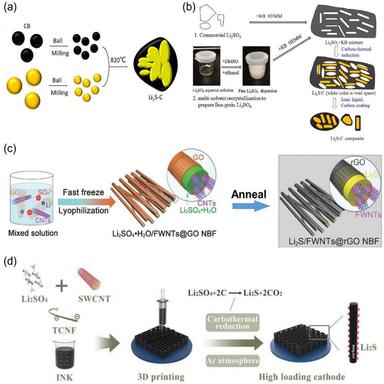
The schematic of different methods for making Li2S-C composites via carbothermal reductions based on elemental carbon. (a) Ball-milling Li2SO4-H2O and C. (b) Ballmilling Li2SO4 and C with subsequent carbon coating. (c) Li2S/FWNTs@rGO nanobundle forest (NBF) by template synthesis . (d) 3D printing an ink including Li2SO4 and CNTs . Reproduced from Refs. with permission from Wiley and Elsevier.